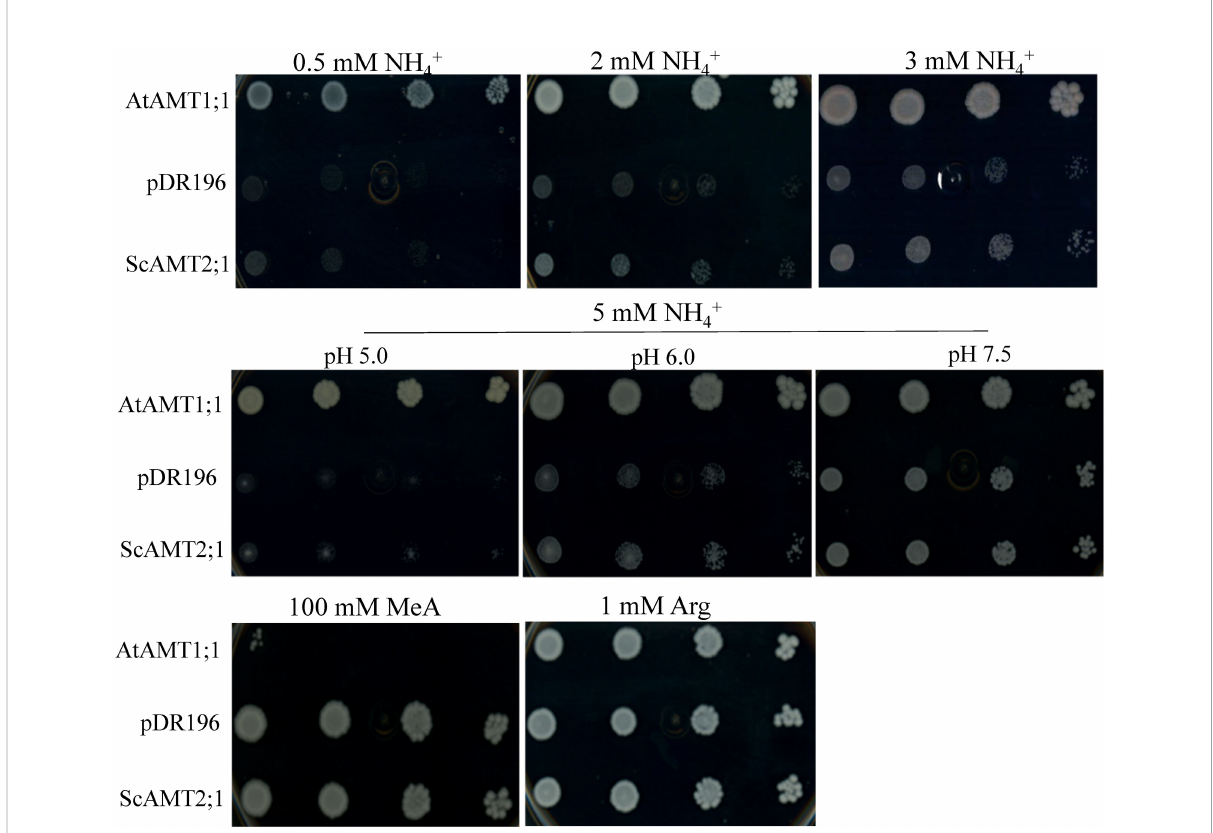
FIGURE 3 Functional complementation of the yeast mutant defective for ammonium uptake. Growth of the ammonium transporter-de fi cient yeast strain triple mep D (31019b) expressing AtAMT1;1 (positive control), the empty pDR196 vector (negative control), or ScAMT2;1 on media supplied